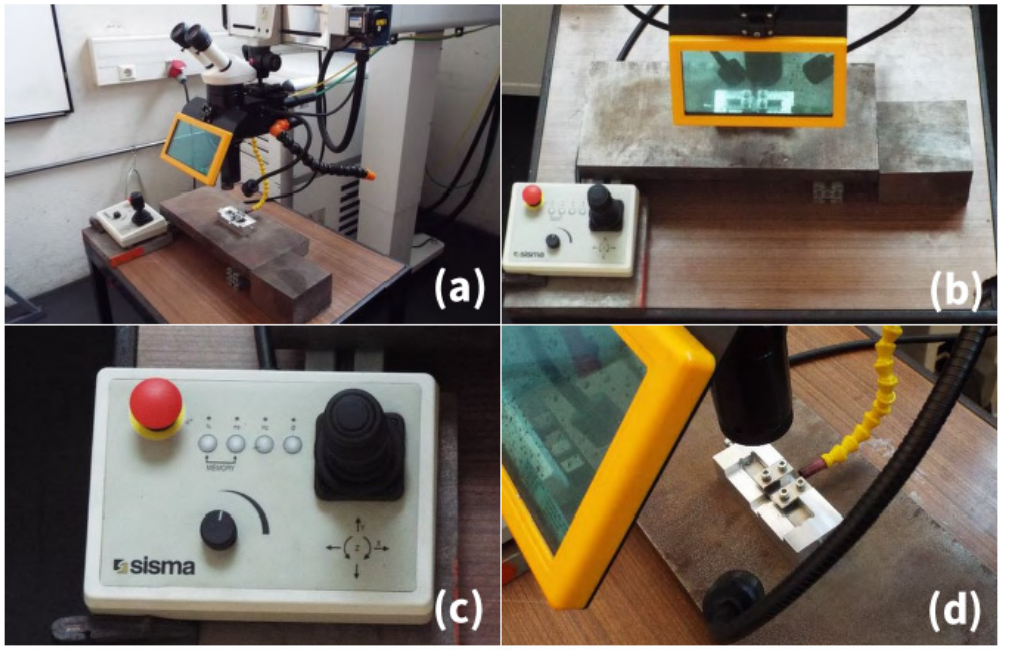
Figure 3. Experimental setup: ( a ) overview of the experimental setup; ( b ) shielding; ( c ) control; ( d ) clamping system.